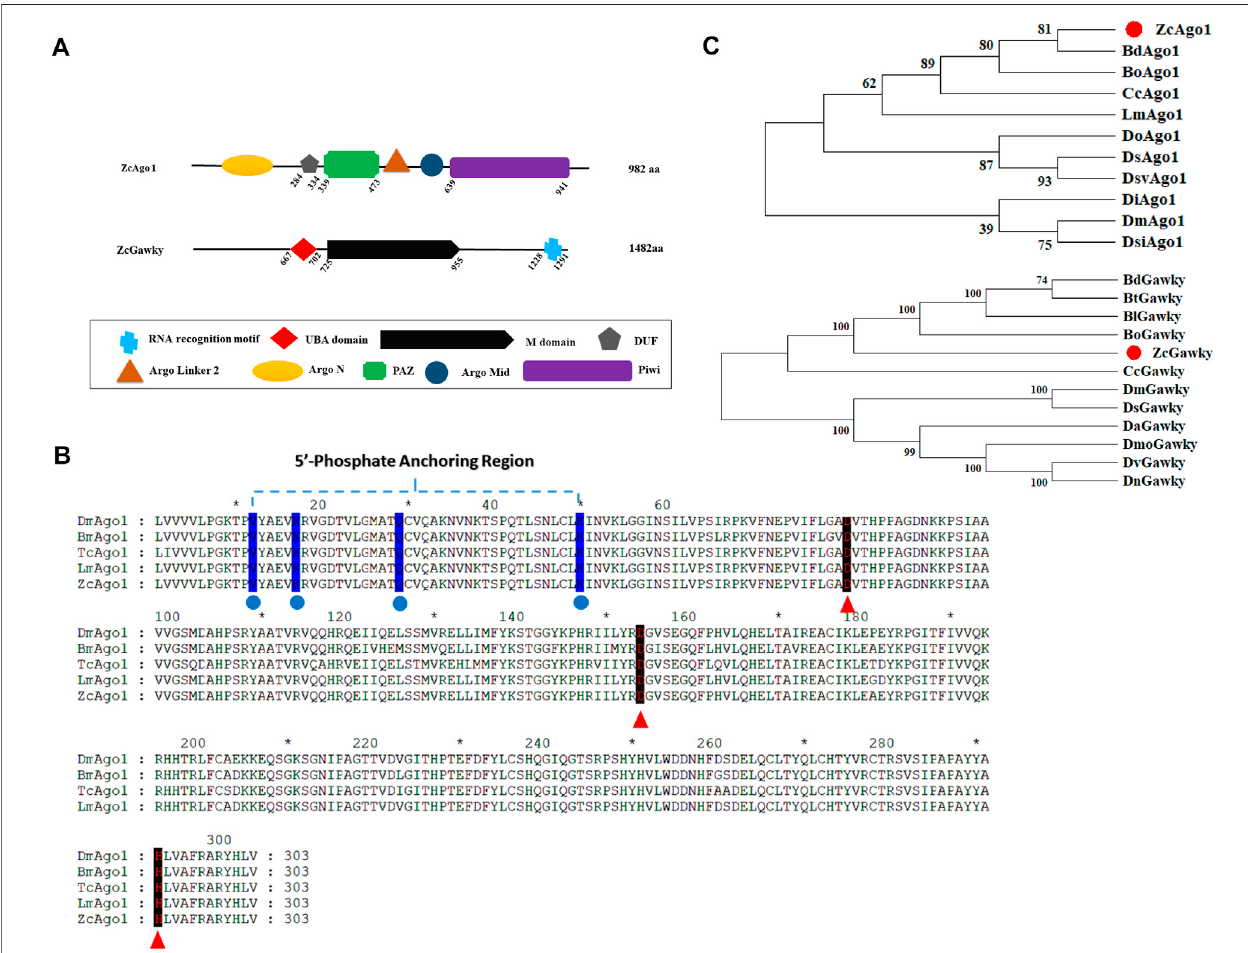
FIGURE1 | Bioinformatics analysisofAgo1and Gawky proteins in Z.cucurbitae . (A) Domain architectures ofZcAgo1and ZcGawky. Both proteins are involved in miRNA-mediated mRNA silencing. Ago1 contains the PAZ and PIWI domain, while Gawky contains UBA (ubiquitin associated, M (mid) domain, and RRM (RNA recognition motif). (B) Motif analysis of Ago1. Comparison of the characteristic PIWI domains in Ago1 proteins from different species. The protein sequences include ZcAgo1 (XP_011189086.1), Ago1 from D. melanogaster (DmAgo1: NP_523734), B. mori (BmAgo1: BAF73719.1), T. castaneum (TcAgo1: CDW23160.1), and L. migratoria (LmAgo1:KF006338).Theconservedaminoacidresiduesinvolvedin5 ′ endrecognitionsitesaremarkedwithbluecolorandtheconservedAsp,Asp,andHis (DDH) triad residues are pointed out with red arrowheads. (C) Phylogenetic tree for Ago1 and Gawky from different insect species. MEGA-X was used for tree construction following the neighbor-joining method with 1000 bootstrap repetitions per test re-sampling. The level of bootstrap support for each branch is represented with numbers at the node. Gene accession numbers and full names are shown in Supplementary Table S1 .